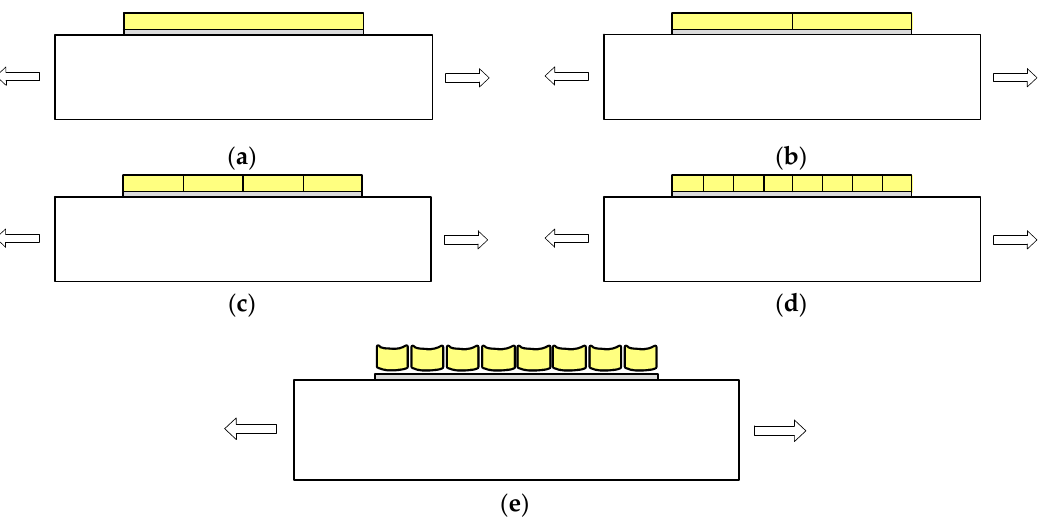
Figure 5. Schematic representation of the cracking and delamination behavior of the ceramic surface layer in the tensile test. The stress of the substrate occurs under the applied load ( a ); the hard coating cracks ( b ) and fragmentation occurs ( c ) and ( d ) the delamination of the hard coating detaches from the adhesion layer ( e ).